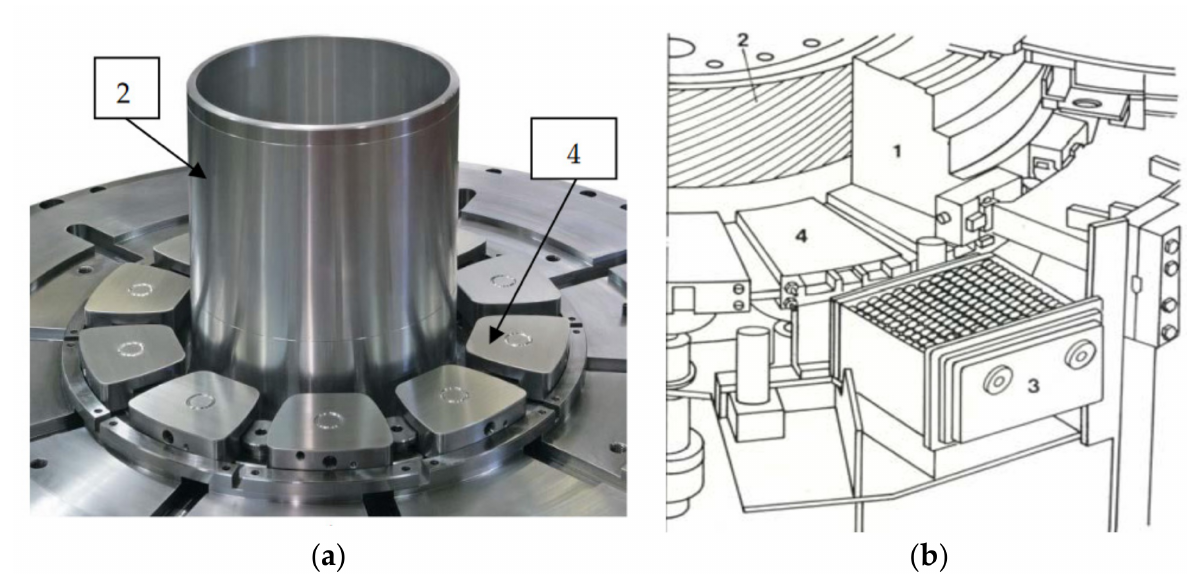
Figure 1. Tilting pad thrust bearing: ( a ) courtesy of Waukesha Bearings; ( b ) courtesy of Itaipu Power Plant.